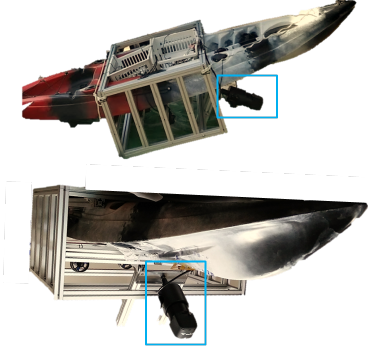
Figure 8. Picture of experimental setup for the turbid water shore of Daecheon